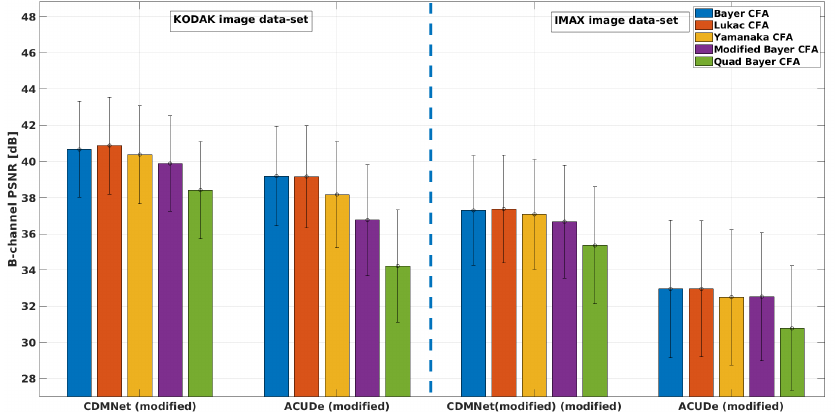
Figure 8. Average PSNR (blue channel) results with standard deviation of the mean: for the two modified generic algorithms (“CDMNet modified” and “ACUDe modified”), for the two data-sets (“KODAK” and “IMAX”), for five different Bayer-like patterns (Bayer, Lukac, Yamanaka, Modified Bayer and Quad